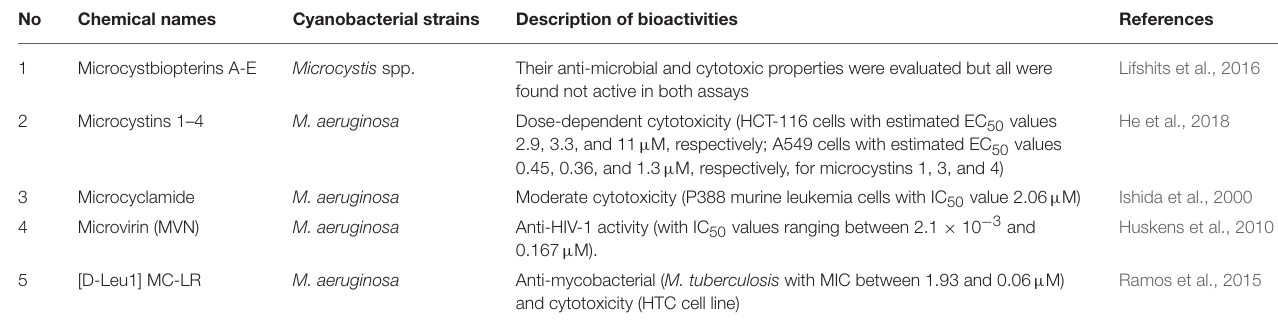
TABLE 3 | Lists of compounds from Microcystis and biological activities.